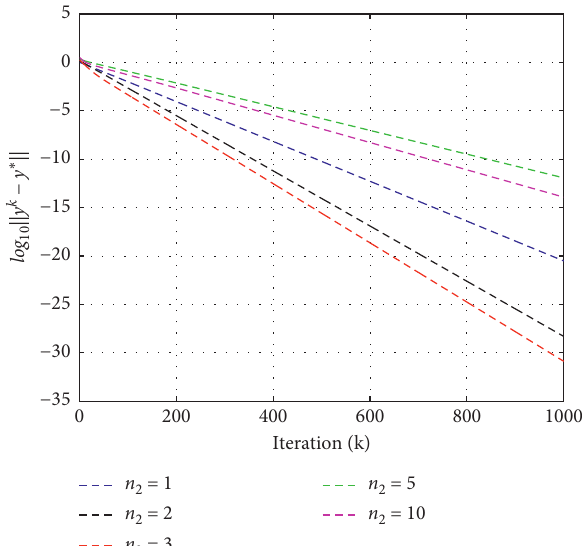
∈ R 10 and 1 and x k 1 2 and x ∗ , respectively. 1 2